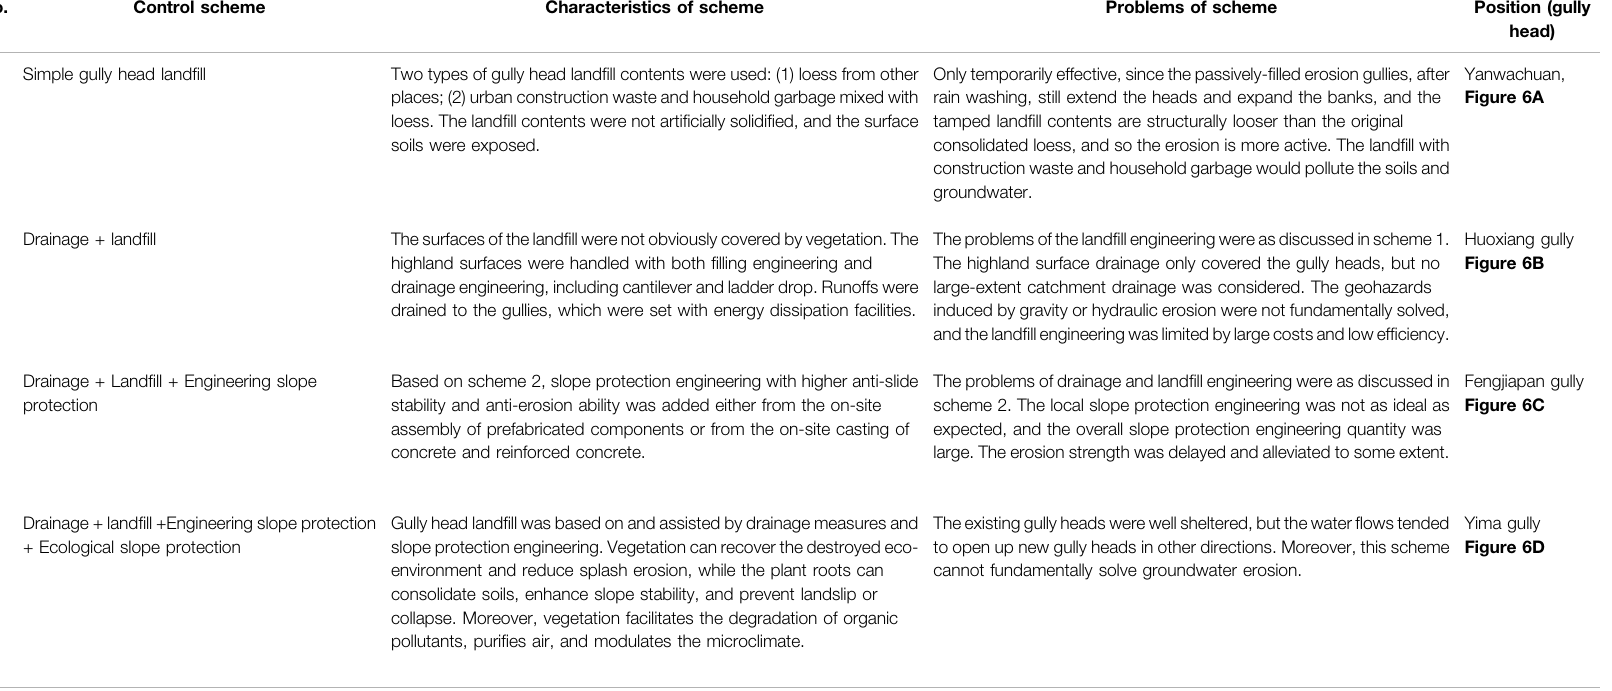
TABLE 2 | Main modes and problems of retrogressive erosion